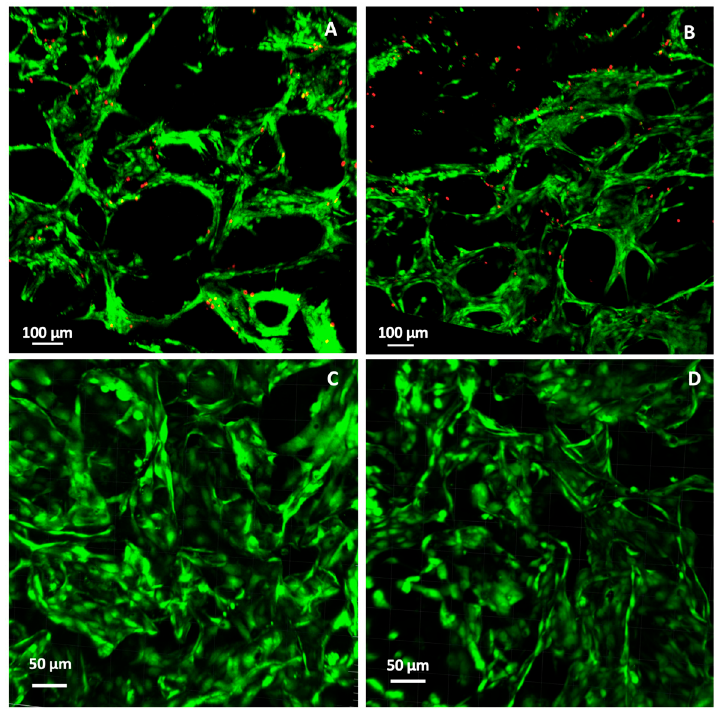
Figure 6. 2D fluorescence confocal microscopy images of the LIVE/DEAD ® assays of ( A , B ) pre-osteoblast cells (MC3T3-E1) and ( C , D ) endothelial cells (HUVECs) in CHT/PCD sponge after ( A – C ) 3-day and ( B – D ) 6-day static culture. Green fluorescence: living cells; red fluorescence: dead cells.